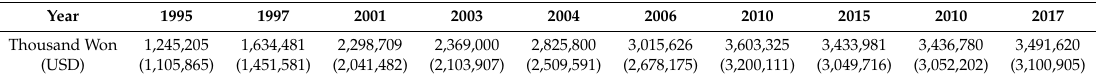
Table 6. Education Committee’s Financial Support for Basic Education.